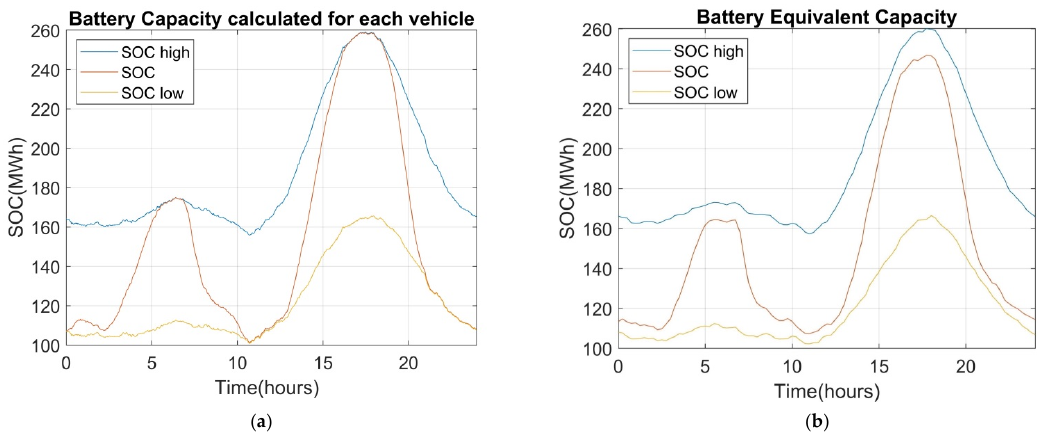
Figure 9. ( a ) Capacity for every PEV battery; ( b ) capacity for equivalent battery.